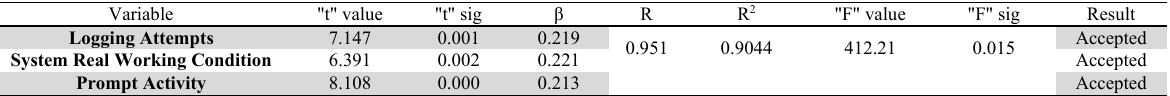
Result of Multiple Regressions Analysis on the Relationship between the of Prompt Activity and Network Security in Com- puter